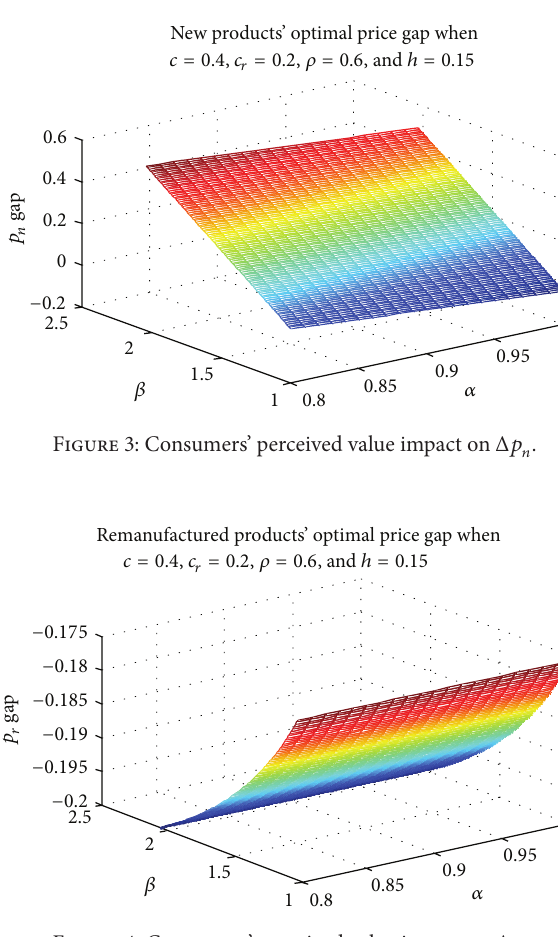
Figure 4: Consumers’ perceived value impact on Δ𝑝 𝑟